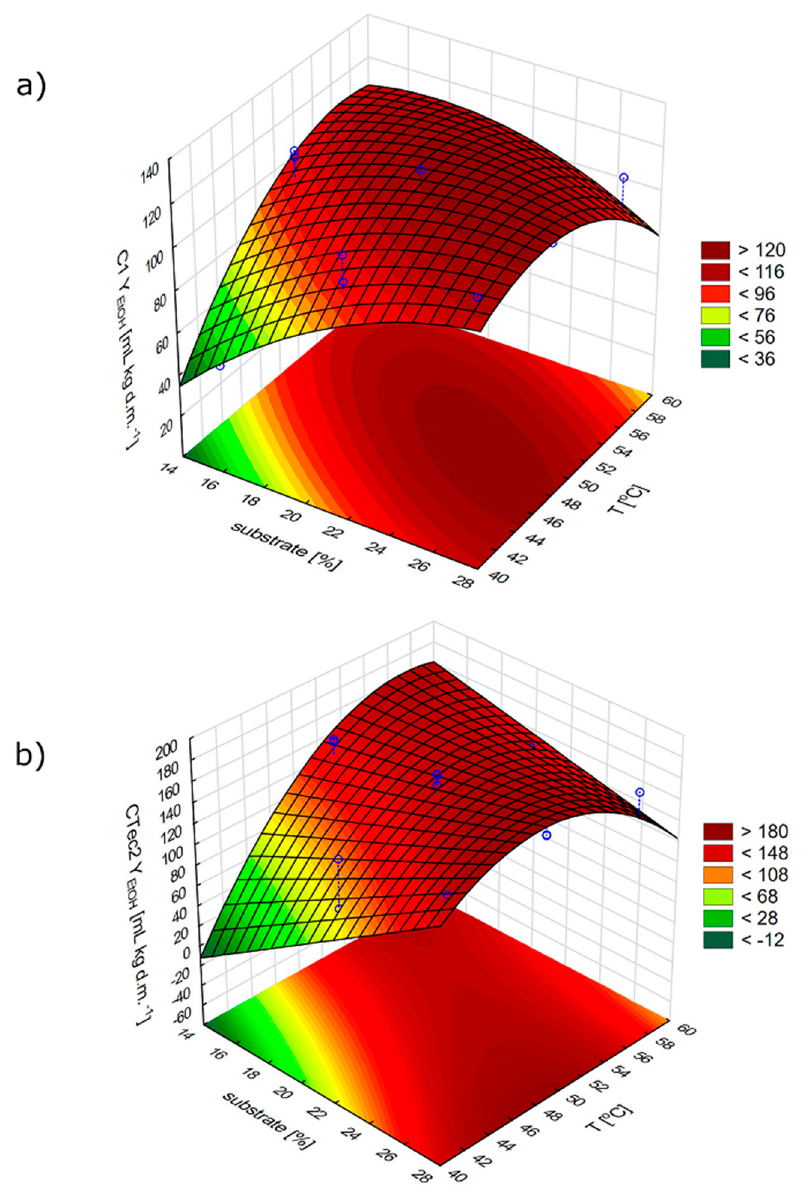
Figure 3. Comparison of response surface plots of the interaction effects between substrate concentration and temperature on ethanol yield in SHF processes with C1 ( a ) and CTec2 ( b ) enzymes.